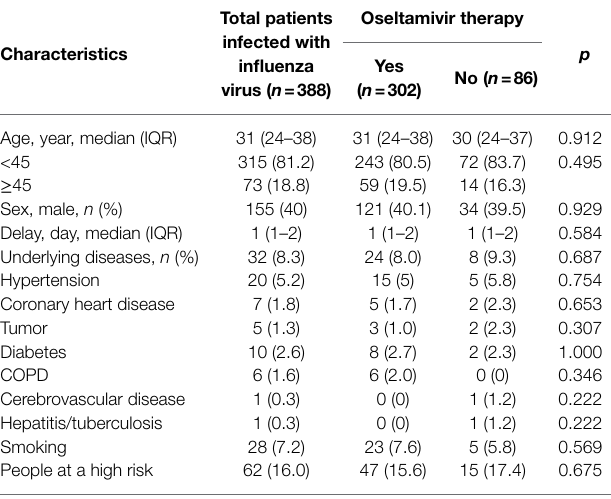
TABLE 2 | The characteristics of the patients infected with influenza virus with or without oseltamivir therapy.